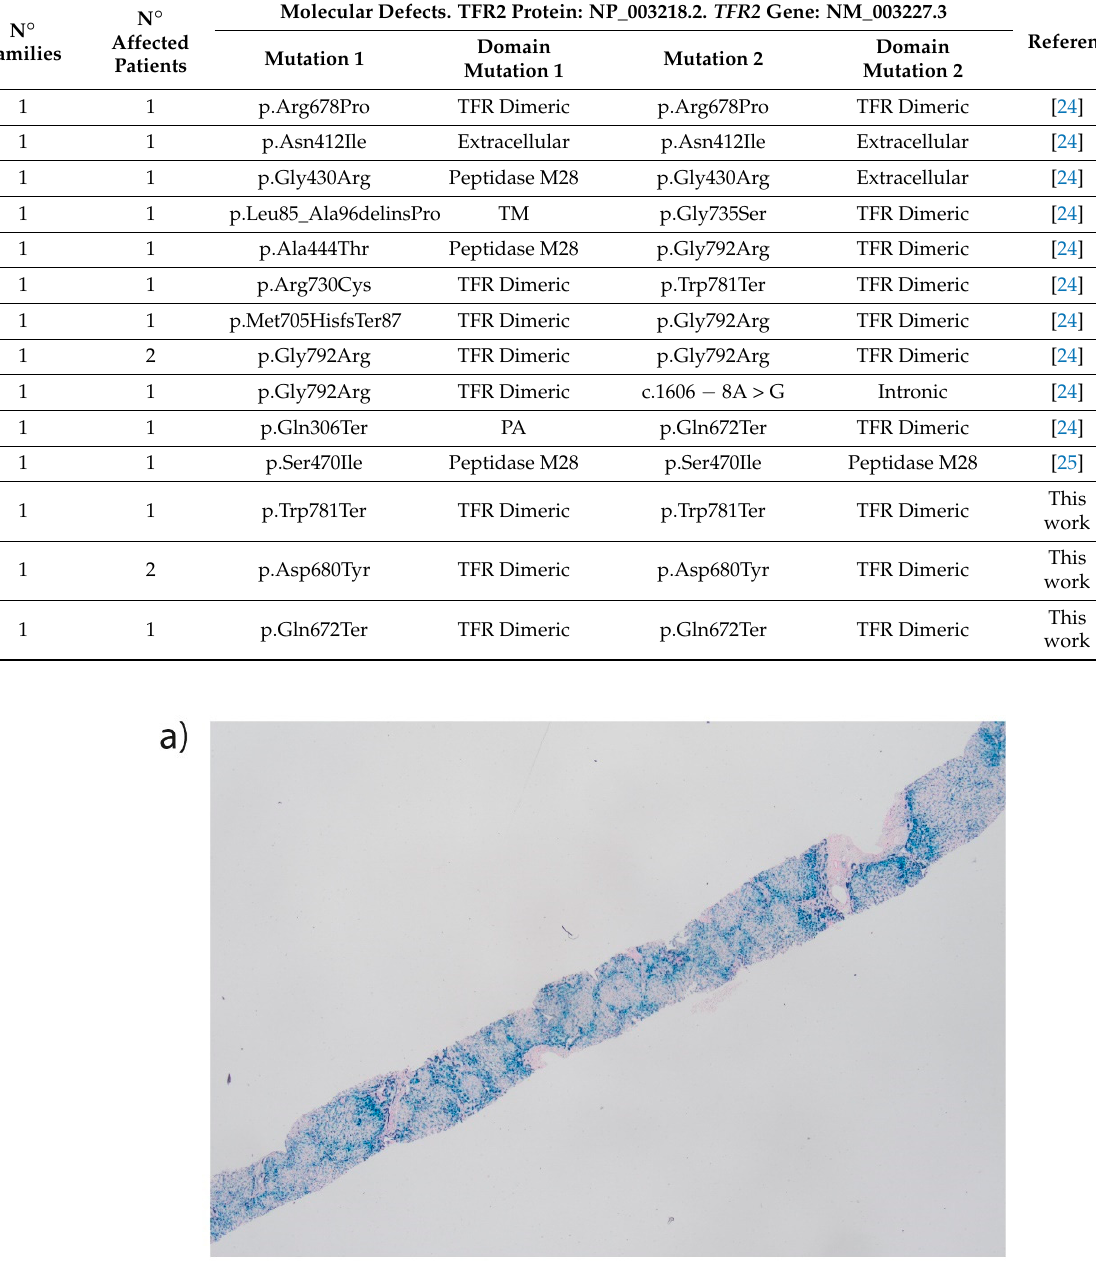
Figure A1. Liver biopsy of a patient with HJV-related hemochromatosis. ( a ). The specimen con- tains several pseudo-lobules and shows massive iron overload in Rappaport zone 1 and decreasing hemosiderin gradient from Rappaport zone 1 to 3 (Perls’ Prussian blue stain, 2X magnification). ( b ) A magnification (20X) of the previous image focusing a portal tract and part of the hepatic lobules showing massive hemosiderin granules in hepatocytes, biliocytes, macrophages and portal vein en- dothelium. Deugnier’s score: Total Iron Score 51 (Hepatic Iron Score 12,9,9; Sinusoidal Iron Score 3,3,3; Portal Iron score 4,4,4).